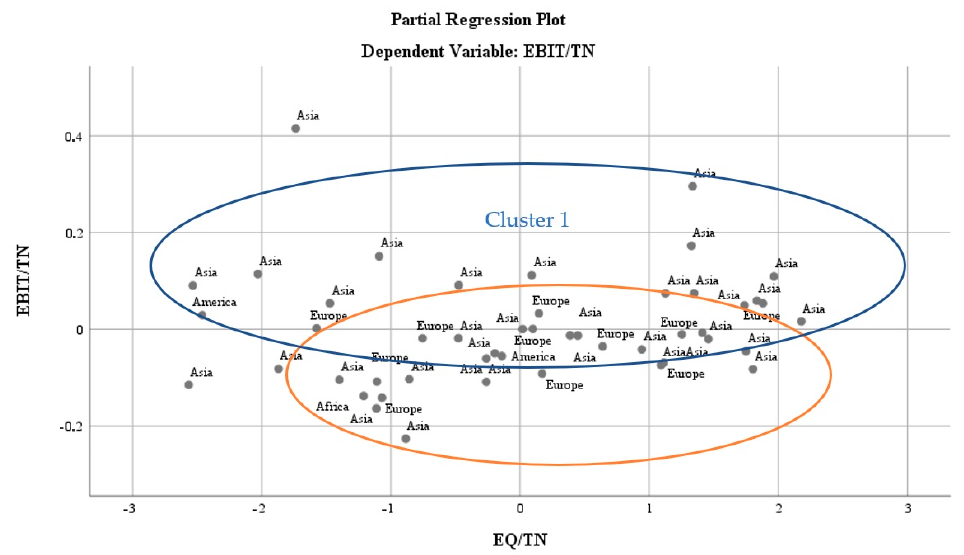
Figure 8. Distribution clusters of the regressor value of return on equity in relation to the overall economic performance rate.